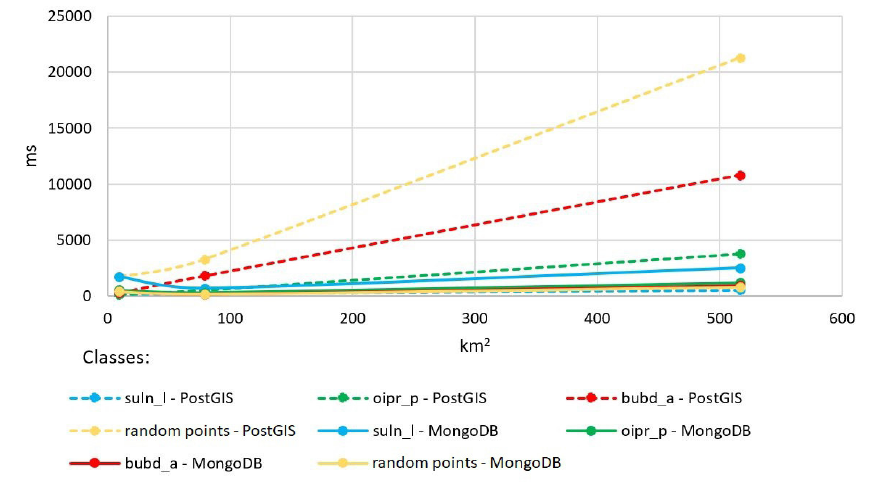
Fig. 2. The query execution time in dependence of the size of the search area for the Intersects